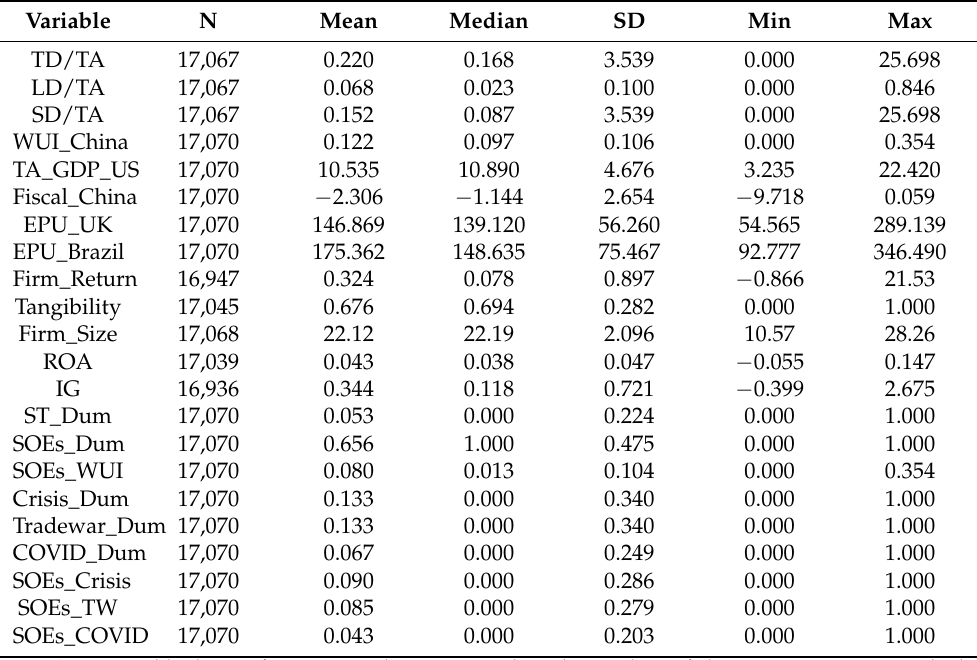
Table 1. Descriptive statistics for the variables